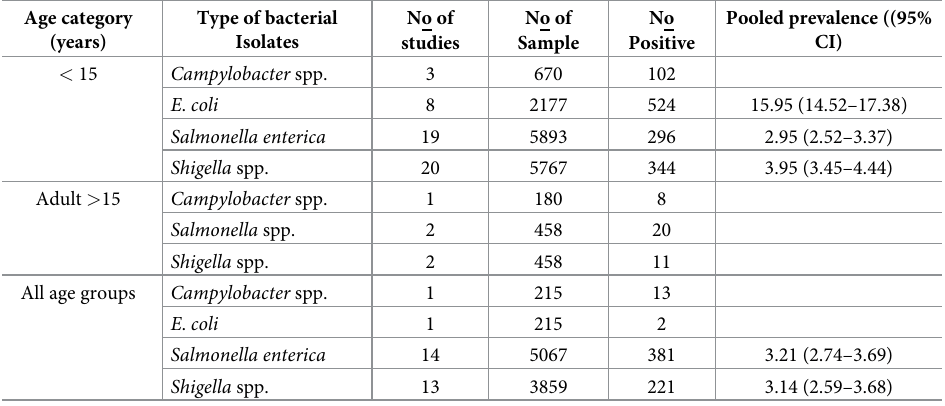
Table 4. Type bacterial isolates among different age groups.